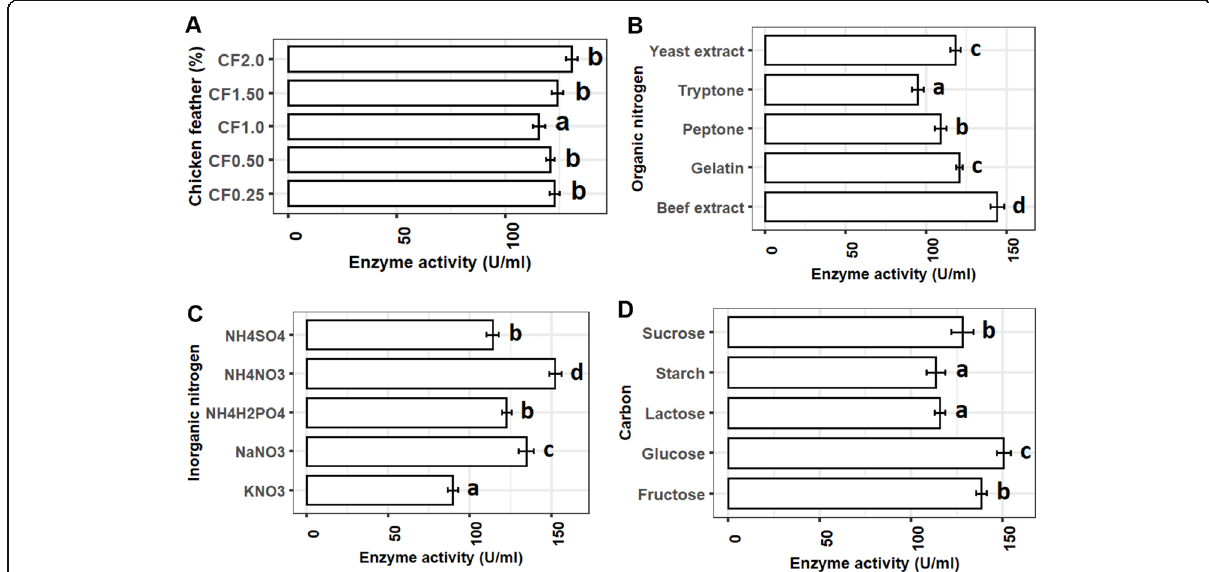
Fig. 3 Effects of different media compositions on production of keratinase by the P. aeruginosa YK17 isolate. a Chicken feather (%). b Organic